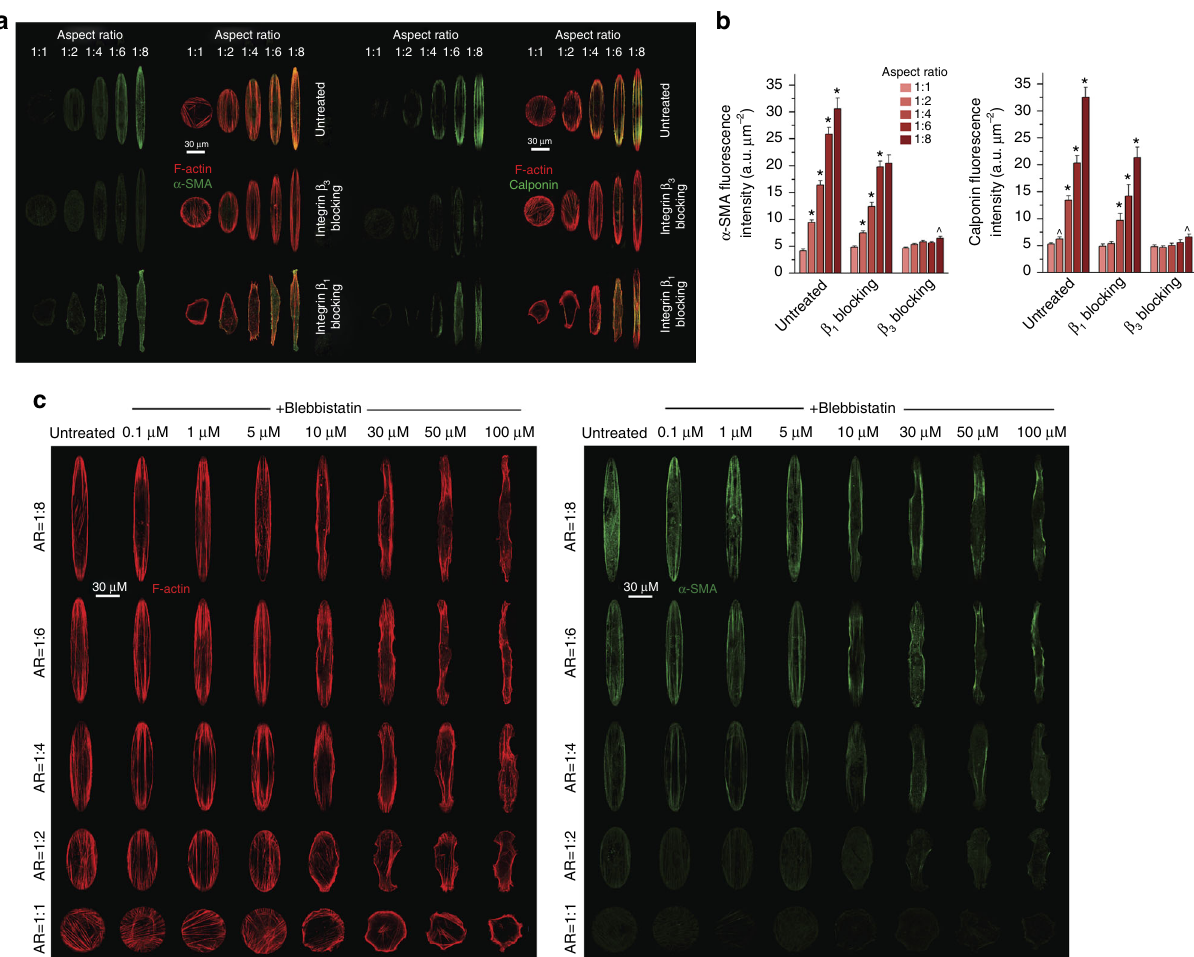
Fig. 5 Shape signals control maturation of vascular smooth muscle cells. a Representative images of SMCs plated on ellipsoid micropatterns and stained either for (left) α -SMA (green) and F-actin (red), or (right) calponin (green) and F-actin (red). In untreated SMCs, both α -SMA and calponin showed increased expression with increasing aspect ratio that was colocalized with actin stress fi bers, which is a hallmark of contractile SMC maturation. When integrin β 3 activation was blocked, this phenotypic feature was abolished. Treated cells with β 1 blocking antibodies had no effect on the shape-driven phenotype even though the cells failed to comply with the ellipsoid micropatterns. b Quantitative analysis of α -SMA and calponin in SMCs plated on ellipsoid patterns with or without integrin β 1 or β 3 blocking antibodies. Values are given as mean ± SEM; n = 80, chosen randomly from eight different slides cultured independently (^ p < 0.05, * p < 0.01 vs. previous ratio; one-way ANOVA comparisons independent for each condition). c SMCs were treated with varying concentrations of blebbistatin from 0.1 to 100 μ M for 12 h before fi xation and stained for F-actin (red) and α -SMA (green). Both stress fi ber integrity and compliance of the cells with the micropatterns decrease with increasing blebbistatin concentration; however, α -SMA expression shows little change with the increasing blebbistatin plasma membrane mobility and molecular abundance of β 1 and β 3 in SMCs and human podocytes. For the mobility measure- ments, human podocytes and VSMC were transfected with mEmerald- β 1 integrin or mEmerald- β 3 integrin (Supplementary